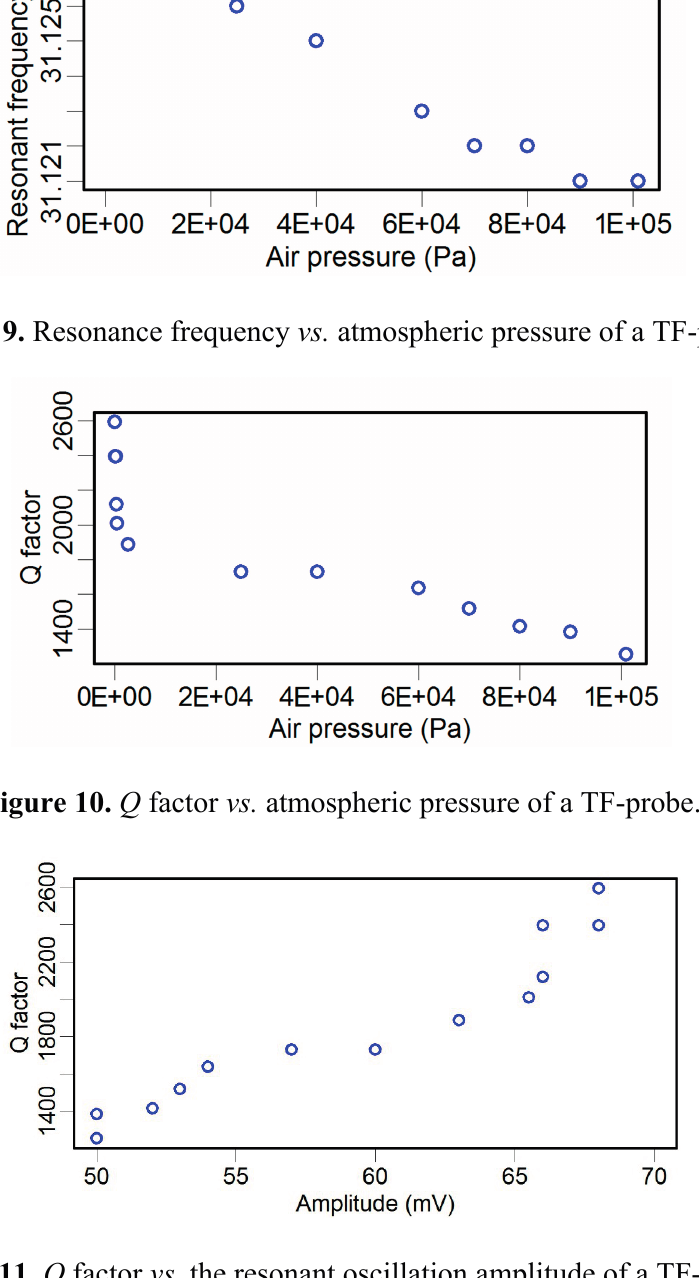
Figure 11. Q factor vs. the resonant oscillation amplitude of a